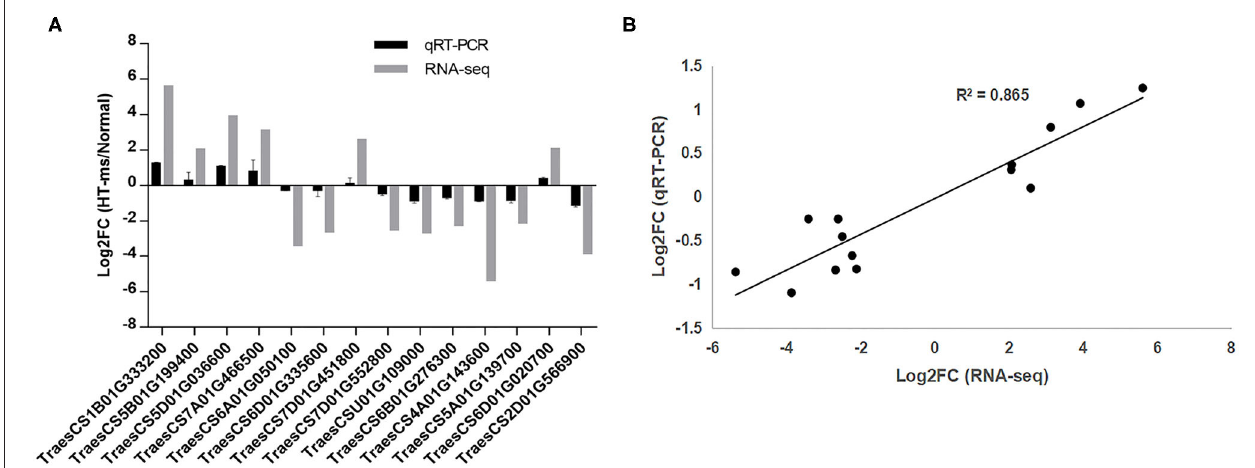
FIGURE 10 | Quantitative real-time PCR (qRT-PCR) validation of the RNA sequencing results for some hub DEGs. (A) Log2 (FC) represents the logarithm of the FC in expression for HT-ms anthers relative to Normal anthers. (B) Correlation analysis of hub DEGs between qRT-PCR and RNA-seq data. The scatter plot indicates the log2-transformed gene expression values in qRT-PCR and